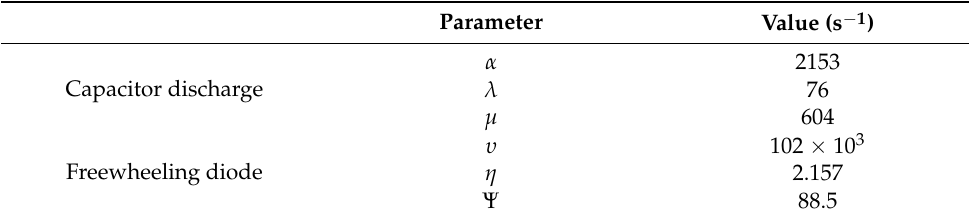
Figure 9. Comparison between analytical and simulation results. Table 3. Parameters of the analytical model.